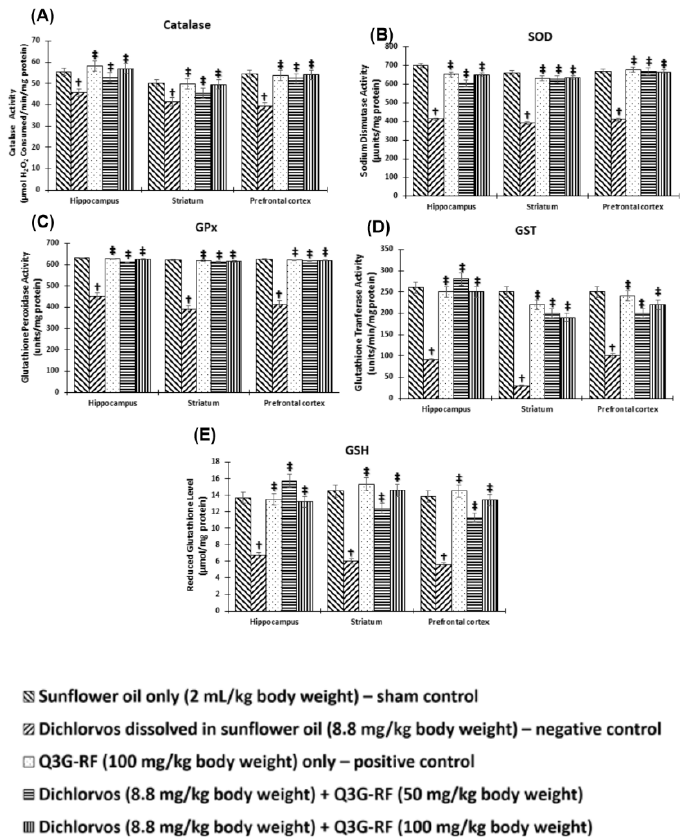
Figure 3. Efficacy of Q3G-RF from S. mombin leaves on antioxidant status in the brain of DDVP- induced neural impairment of female Wistar rats. Activities of Catalase ( A ), SOD ( B ), GPx ( C ), and GST ( D ) as well as GSH level ( E ) of Wistar rats treated with sunflower oil, DDVP alone, Q3G-RF alone, and DDVP + Q3G-RF (50 and 100 mg/kg). Values are expressed as mean ± standard error of mean ( n = 10). Significant differences from the positive control group are indicated by † and from DDVP alone by ‡ , ( p < 0.05). DDVP, Dichlorvos; Q3G-RF, Quercetin-3-O- β -D-glucopyranoside-rich fraction from Spondias mombin .